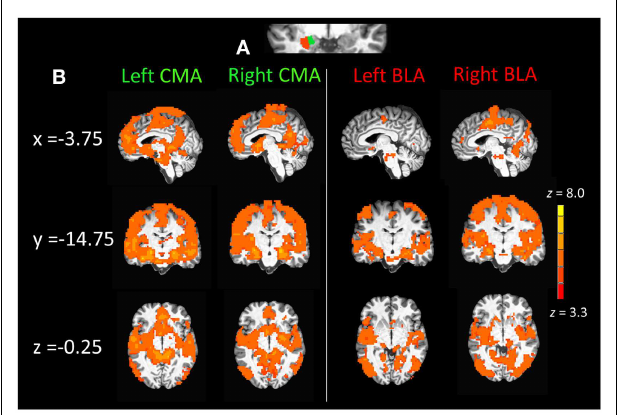
FIGURE 1 | (A) Section of coronal anatomical slice ( y = 1.75,Talairach standard space, 1mm × 1mm × 1mm) with a single subjects basolateral amygdala (BLA) and corticomedial amygdala (CMA) division mask overlays (3mm × 3mm × 3mm) on the left amygdala. (B) Whole-brain resting state functional connectivity maps of the left and right CMA and BLA seeds for healthy control participants ( n = 22), p corrected = 0.01, z (21) > 3.3 and a cluster size of